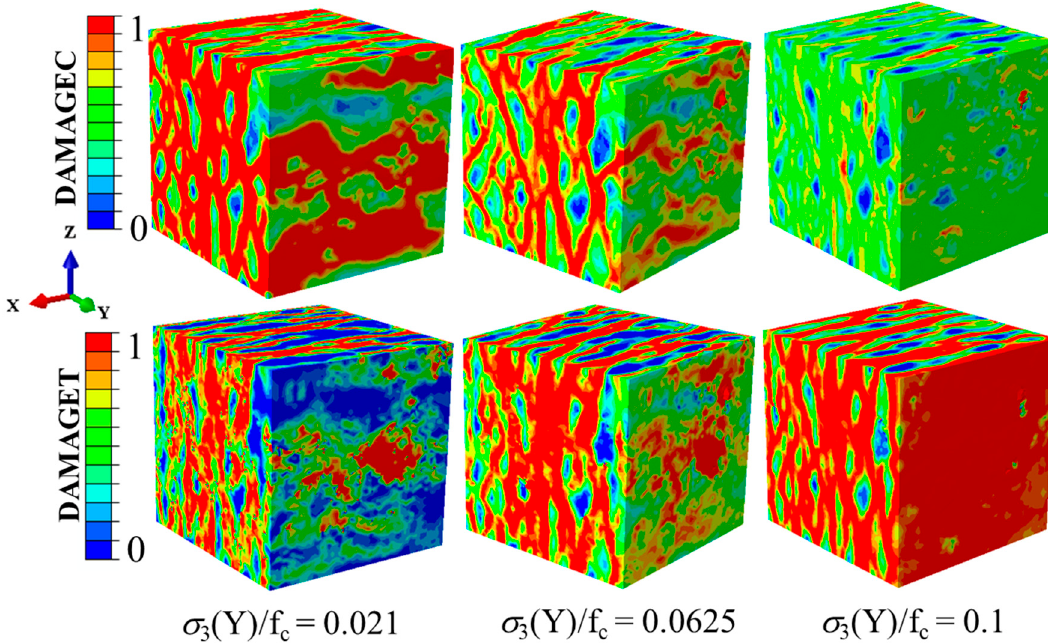
Figure 18. Compressive damage to tensile damage when σ 3 /f c changed under σ 1 (X)/f c = −0.5 .